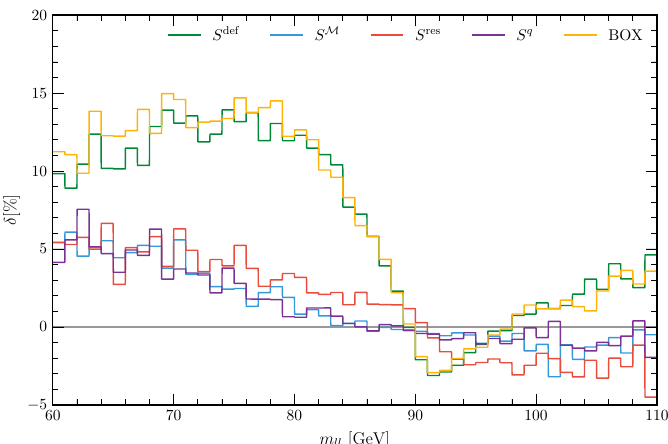
Figure 2 : Relative EW corrections to (cid:22) B for the invariant-mass distribution of the lepton pair. Results for di(cid:11)erent choices for the underlying S functions are shown, where S def , S M , S res , and S q are de(cid:12)ned in section 2. We also show the result of the Powheg-Box which agrees well with the corrections based on S def